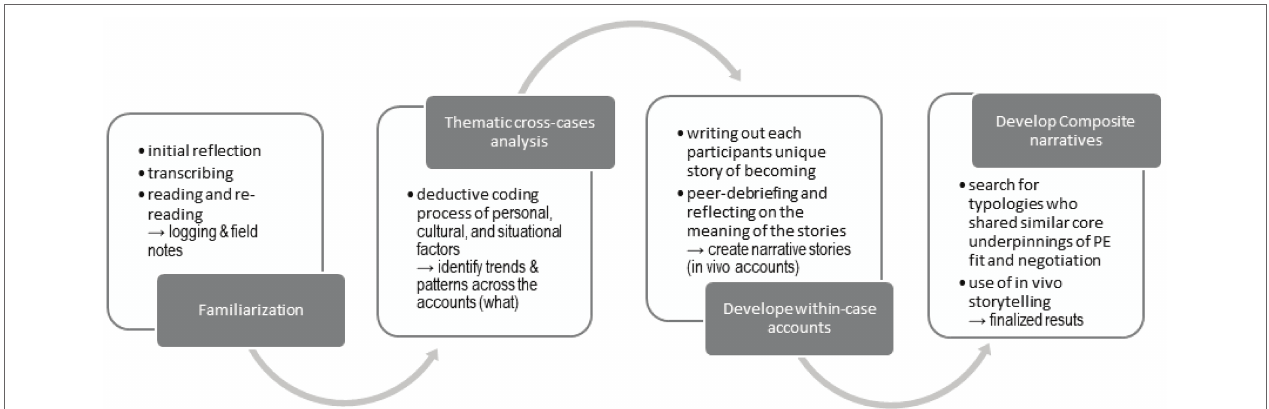
FIGURE 1 | The process of data